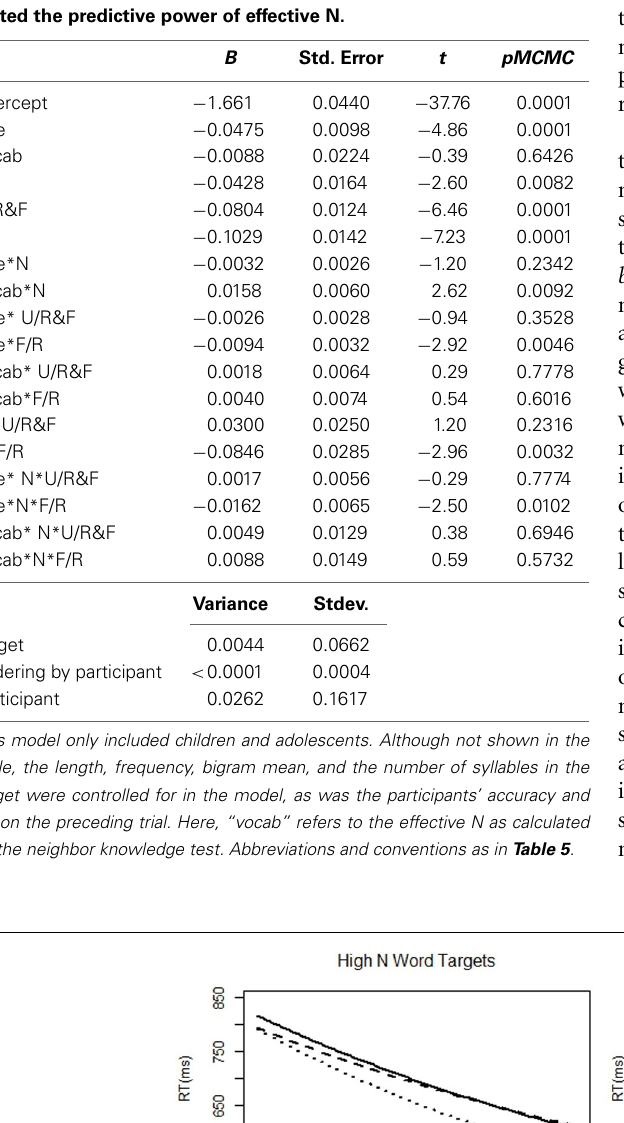
Frontiers in Psychology | Cognitive